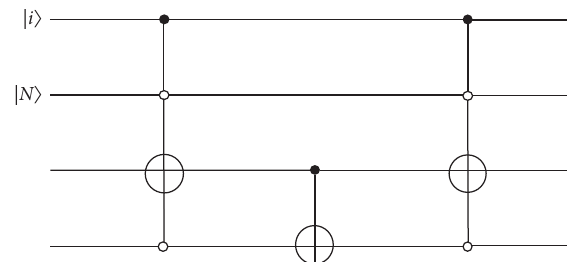
Figure 2: Quantum circuit of CMP operation; • represents the control qubit conditional being set to